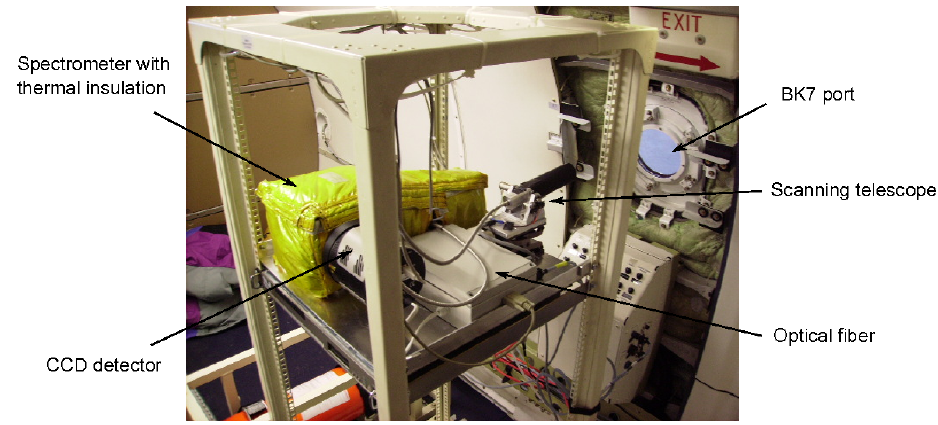
Fig. 1. The Airborne Limb Scanning Differential Optical Absorption Spectrometer (ALS-DOAS) onboard the Safire ATR-42 aircraft. A scanning telescope collects scattered sky-light at different angles near the horizon, this light being transmitted through an optical fiber to a grating spectrometer. A CCD detector is used to record the spectra. See text for technical details.